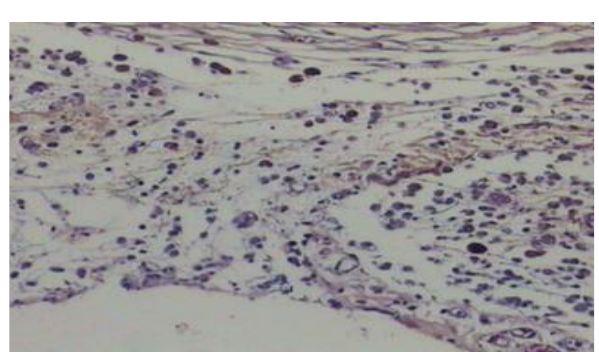
FIGURA 4 – Fotomicrografia do processo inflamatório crônico. Legenda: 7º dia do pós-operatório, SGA(coloração HE., aumento